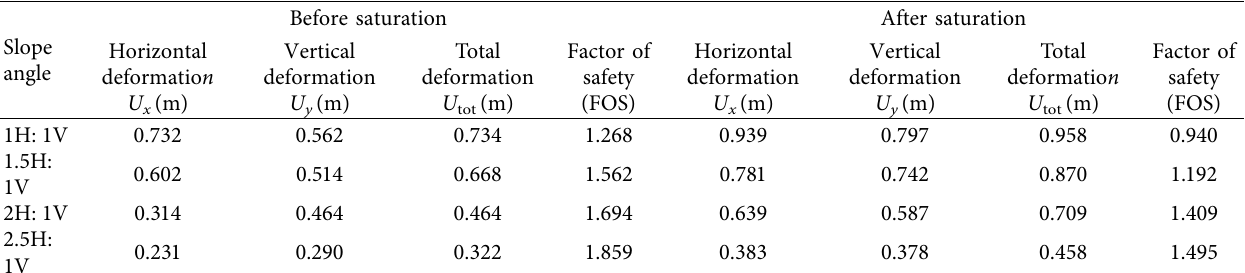
Table 7: FOS and slope deformation values for slope-6 by Plaxis 2D before and after saturation. Before saturation After Slope angle